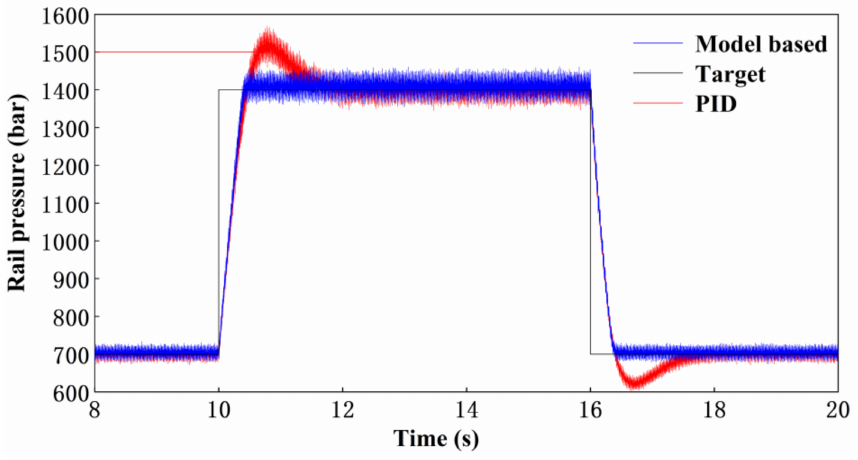
Figure 19. The 700–1400 bar rail pressure change.